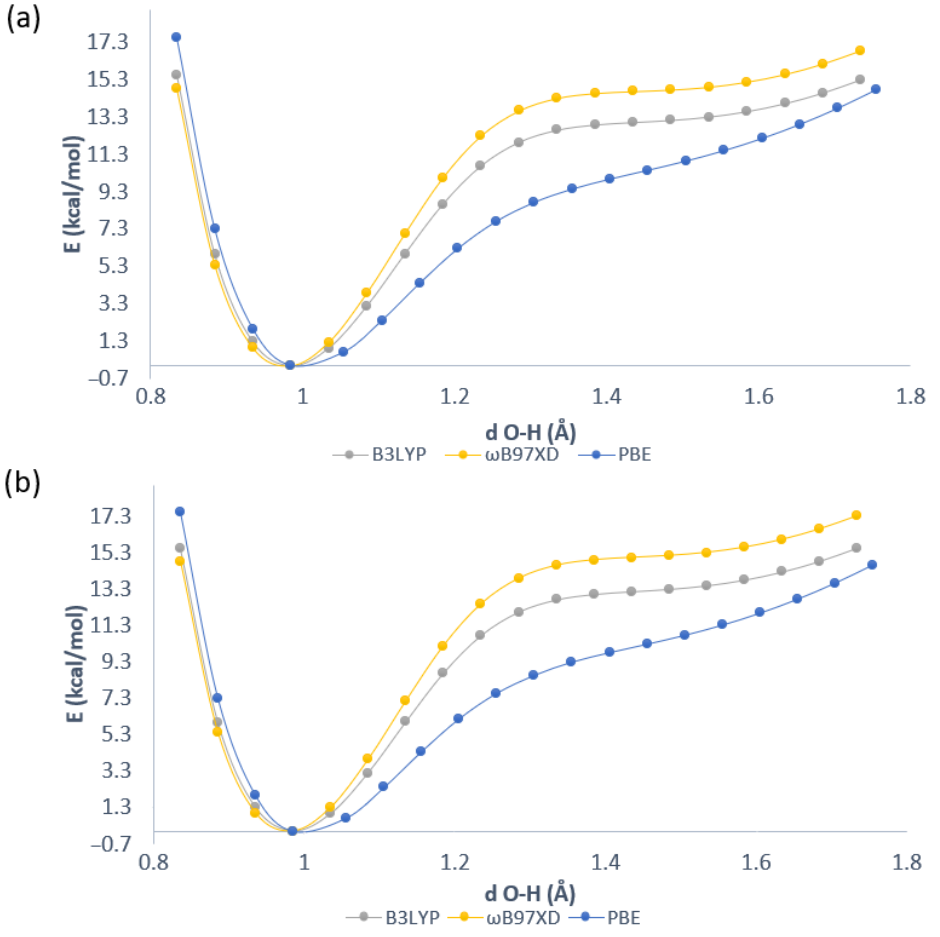
Figure 3. The potential energy scans for the proton motion in the hydrogen bridges of ( a ) 1,8- dihydroxy-9,10-anthraquinone ( 2 ) and ( b ) 1,8-dinitro-4,5-dihydroxy-anthraquinone ( 3 ). X axis: donor- proton ( O 1- H a )